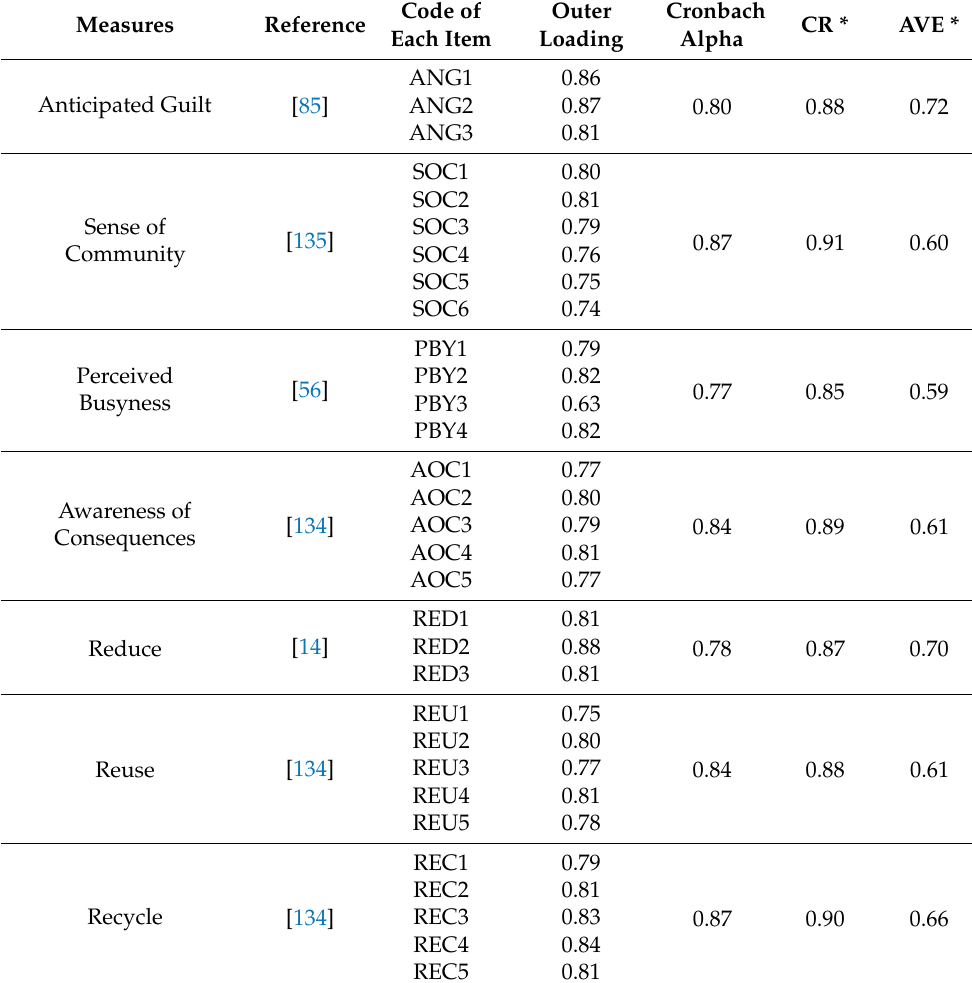
Table 3. Results of Measurement Model.